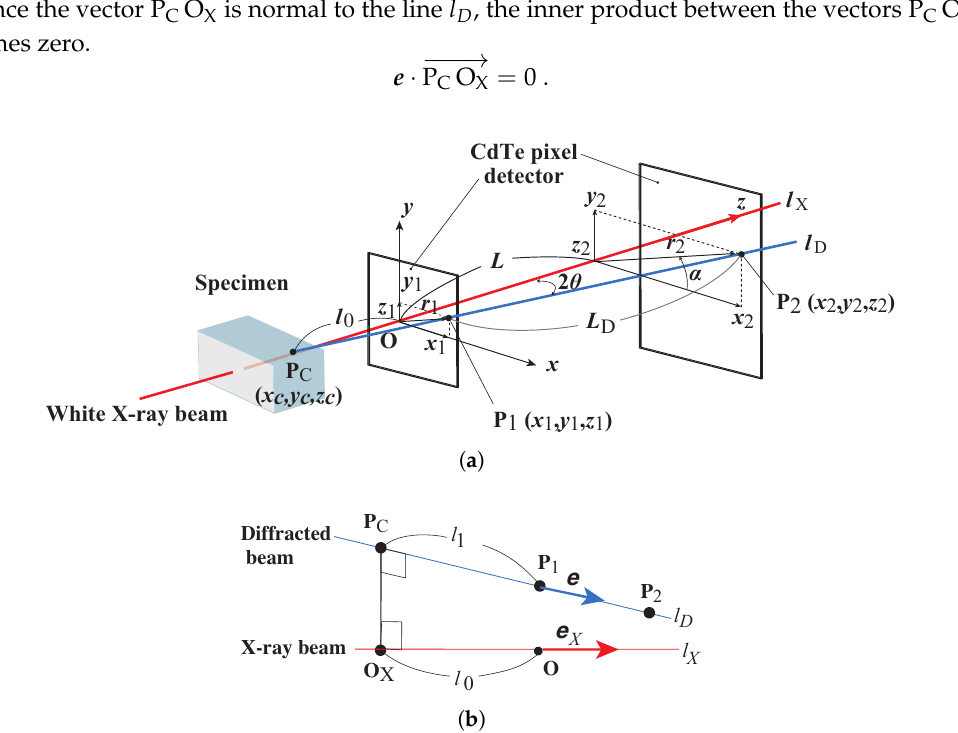
Figure 1. Double-exposure method with a synchrotron white X-ray source. ( a ) The line l X is the transmitted white X-ray beam and the line l D is the diffracted X-ray beam from a coarse grain. The diffracted beam is detected by the CdTe pixel detector at P 1 and P 2 ; ( b ) details of P C , where the lines of l X and l D intersect. The line P C O X is normal to lines l X and l D